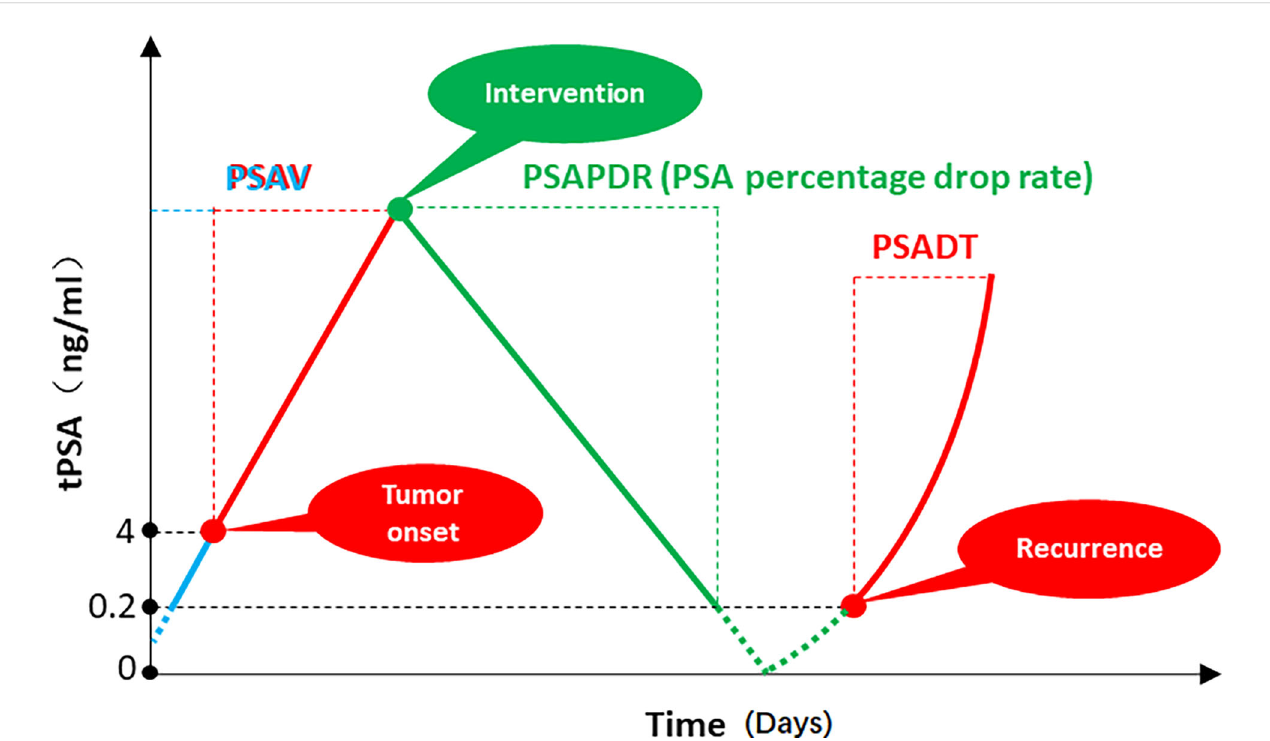
FIGURE 1 PSA velocity (PSAV), PSA doubling time (PSADT), and PSA percentage decline rate (PSAPDR). The concept of PSAV is based on the linear relationship between PSA growth and time. The calculation formula is [(PSA2 - PSA1) + (PSA3 - PSA2)] ÷ 2. The concept of PSADT is based on the power function relationship between PSA growth and time, which is a descriptive indicator of the rate of PSA re-increase in PCa patients after treatment. (t2 - t1) lg2 ÷ (lgPSA2 - lgPSA1). PSA percentage decline rate (PSAPDR) was de fi ned as the percentage of PSA decline in unit time (days as unit time), which calculated as [(initial PSA- reexamination PSA)] ÷ initial PSA × 100% ÷ days between two PSA